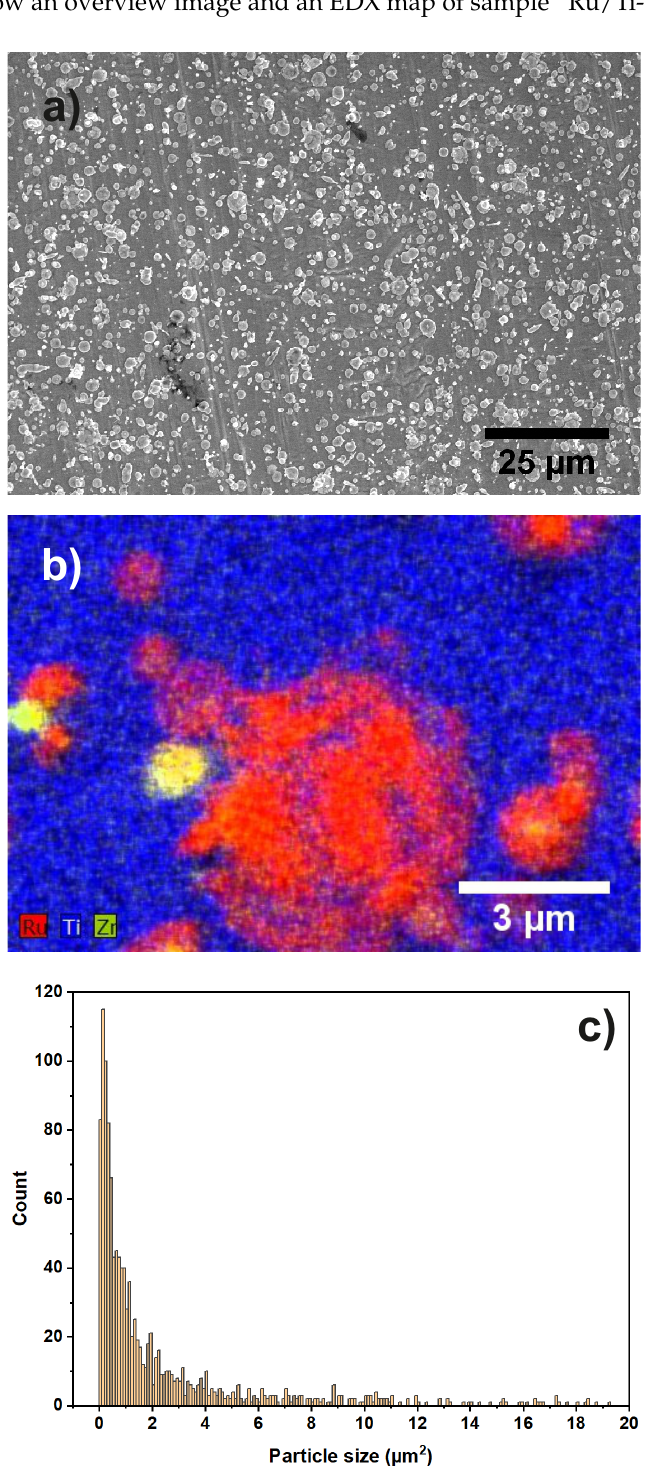
Figure 14. ( a ) SEM overview image of sample “Ru/Ti-1”. Different shapes and sizes of catalyst particles are visible; ( b ) EDX map of several Ru and Zr particles on the Ti support; ( c ) particle size distribution of the catalyst